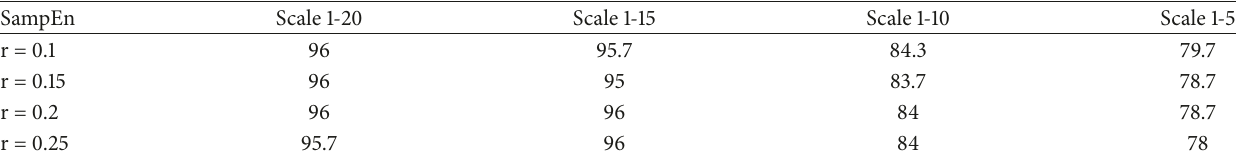
Table 1: Accuracy (%) using linear SVM and 5-fold CV.